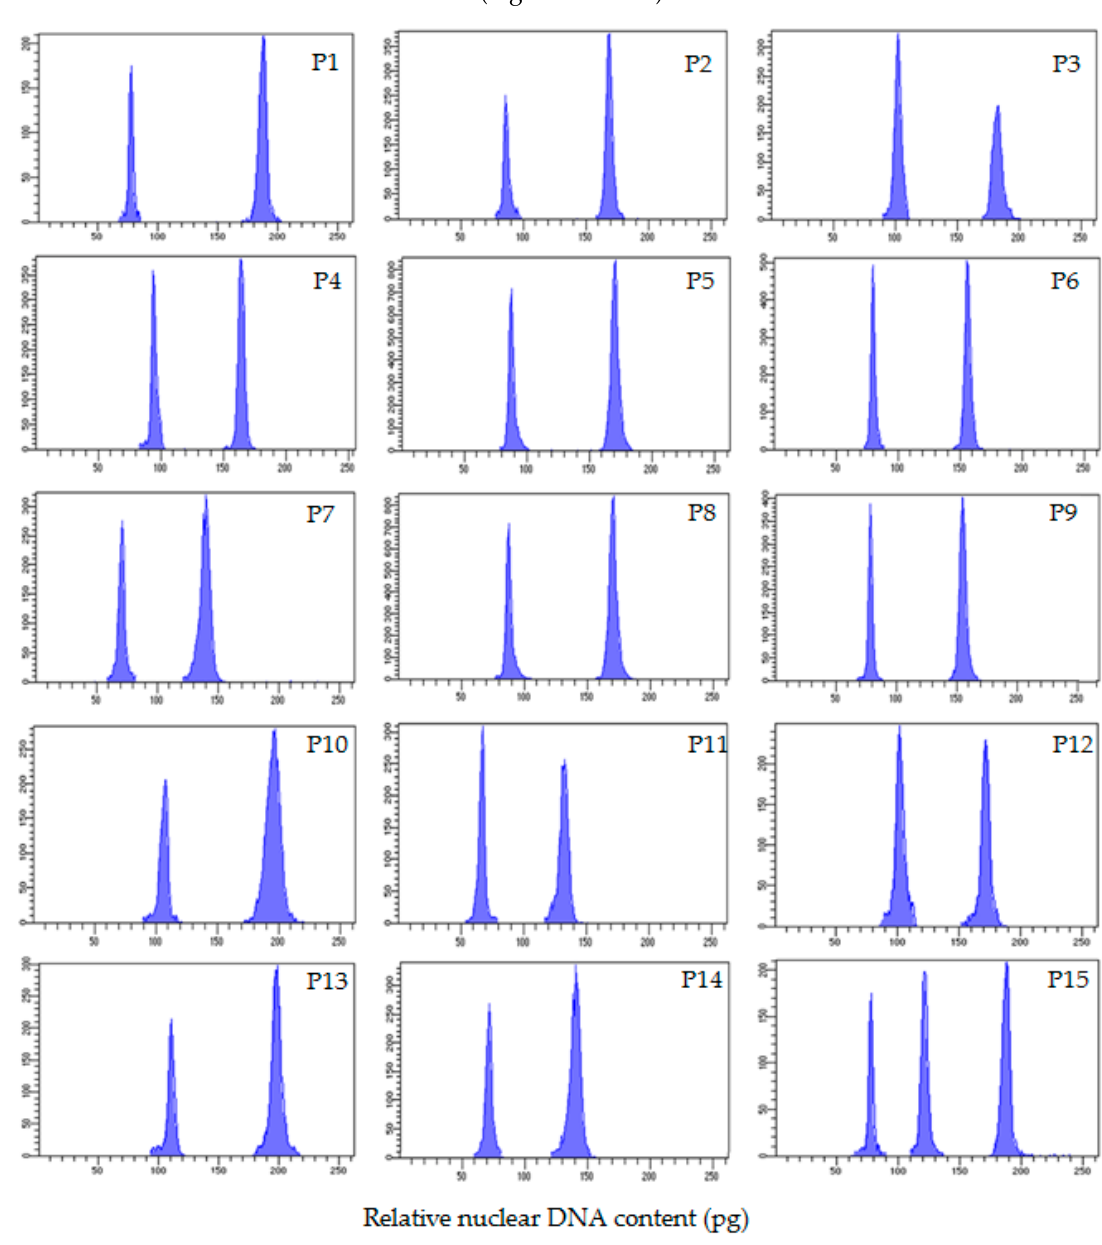
Figure 5. Histograms of nuclear 2C DNA content of 2 x (P1, P9–P14), 3 x (P2, P3), 4 x (P4–P8) and 3 x − 4 x (mixoploid, P15) Hypericum perforatum populations. The left peaks refer to the G1 peaks of the 3 x − 4 x (mixoploid, P15 ) Hypericum perforatum populations. The left peaks refer to the G1 peaks sample and the right peaks refer to the G1 peaks of Glycine max cv. Polanka (2C DNA= 2.50 pg) as of the sample and the right peaks refer to the G1 peaks of Glycine max (L.) Merr. cv. Polanka an internal reference standard plant (P1–P14). In P15, the right peak refers to the G1 peak of the (2C DNA= 2.50 pg) as an internal reference standard plant ( P1 – P14 ). In P15 , the right peak refers to reference standard plant. the G1 peak of the reference standard